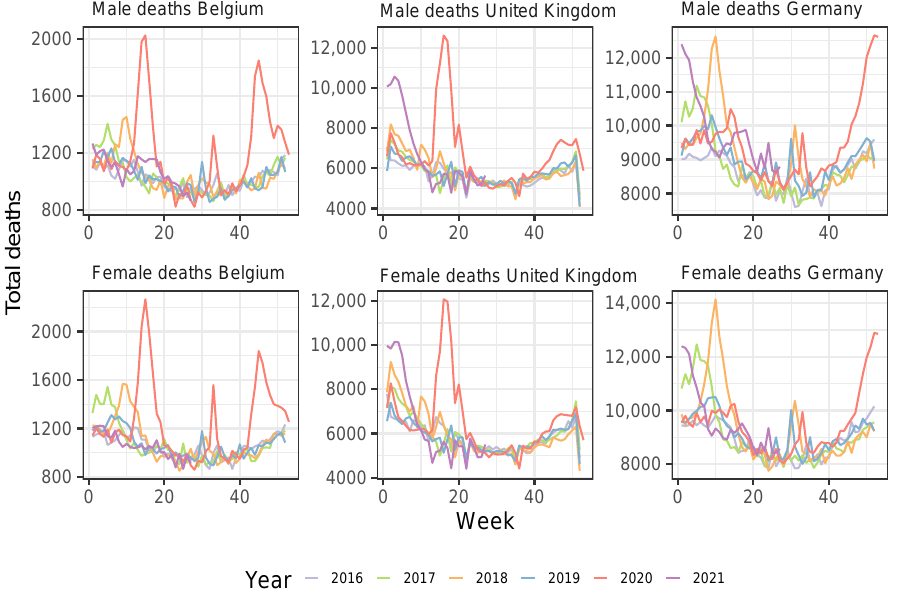
Figure 1. Total weekly deaths in Belgium ( left ), United Kingdom ( middle ) and Germany ( right ) in the years 2016–2020 and 2021 (first 27 weeks) for males ( top ) and females ( bottom ). Eurostat (Belgium) and STMF (United Kingdom and Germany)